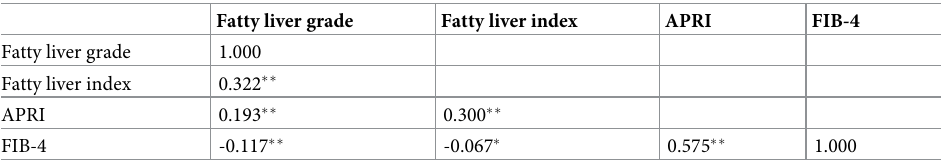
Table 3. Correlation between clinical prediction formulae and fatty live grade.